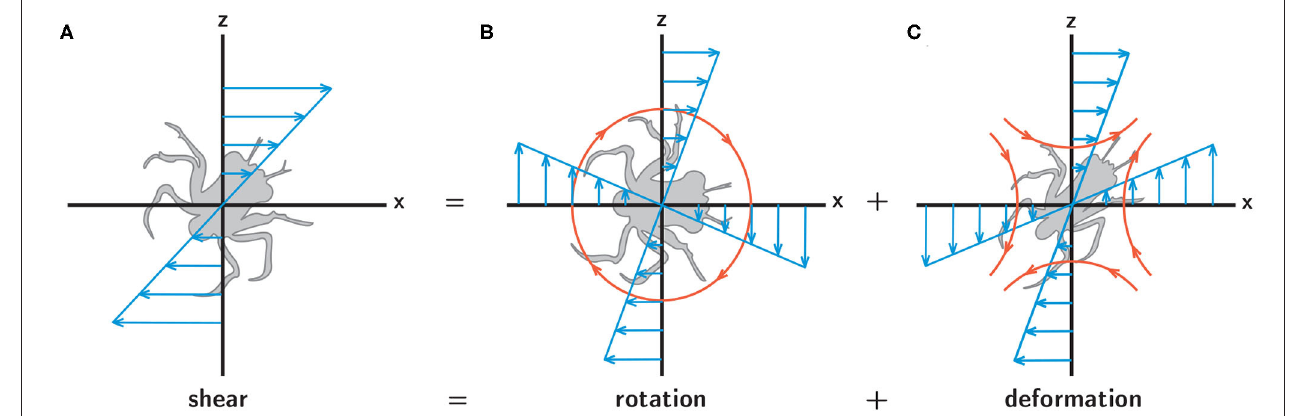
FIGURE 2 | A simple shear flow (A) can be decomposed into fluid rotation (B) and deformation (C) . In each panel the blue arrows indicate the spatial structure of the corresponding flow components, and in (B,C) the orange lines and arrows indicate the resultant rotation (B) and stretching (C) experienced by larvae.